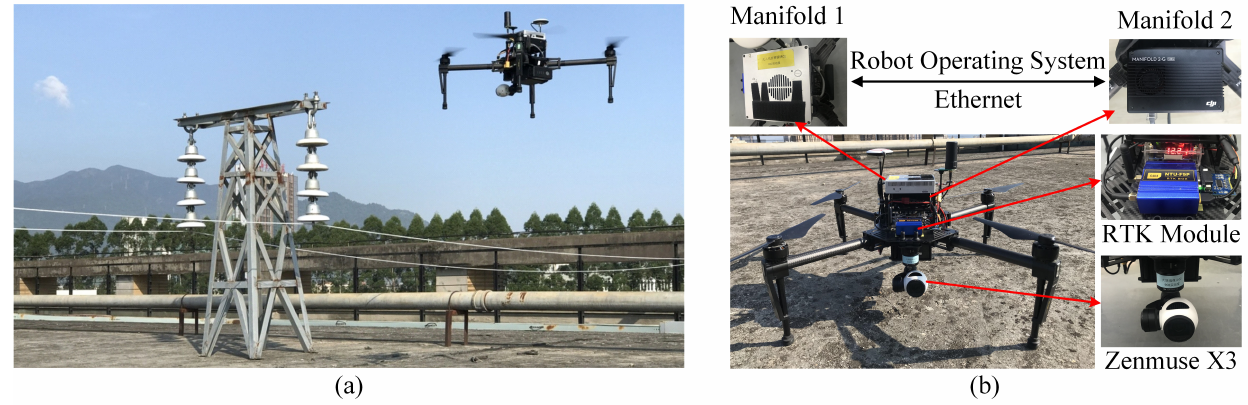
Figure 7. The experiment scene and inspection UAV. ( a ) Simulated transmission tower scenario. ( b ) The prototype of the inspection